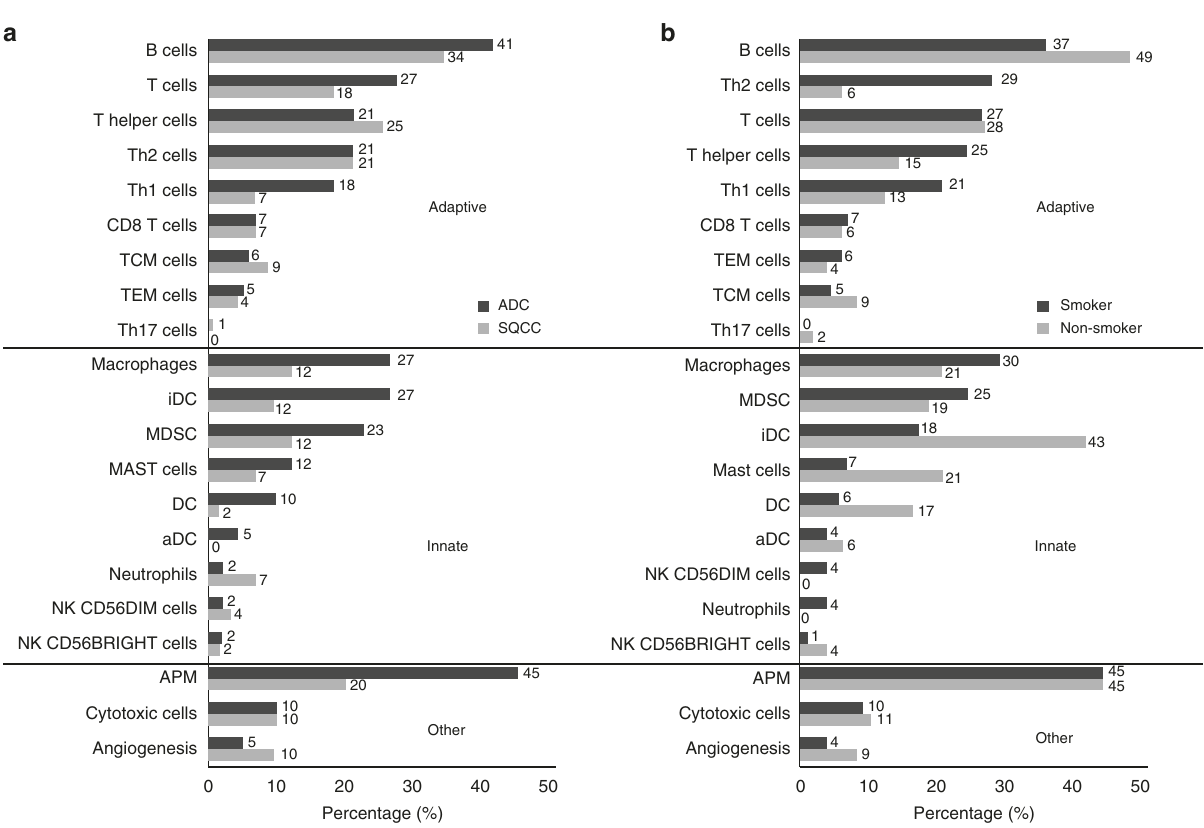
Fig. 3 Tumor-in fi ltrating lymphocytes enrichment pro fi les. a Comparison of TILs enrichment pro fi le in ADC ( n = 131) versus SQCC ( n = 114). b Comparison of TILs enrichment pro fi le in smokers ( n = 84) versus non-smokers ( n = 47) in ADC. Percentage of patients with enriched immune cell signatures were calculated using ssGSEA (see Supplementary Methods). For each immune cell signature, enrichment is de fi ned as q -value ≤ 0.1. Source data are provided as a Source Data fi le. a black bars indicate the percentage of patients having signi fi cant enrichment for the given immune cell type in ADC subtype, while gray bars represent the percentage in SQCC; b black bars represent the percentage of smokers, while gray bars represent the percentage of